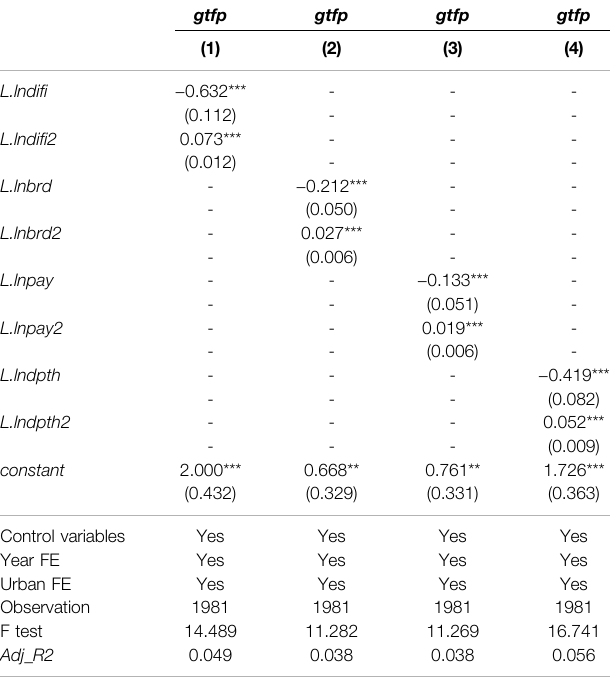
TABLE 8 | Threshold regression results. TABLE 9 | Estimated results of dealing with reverse causal